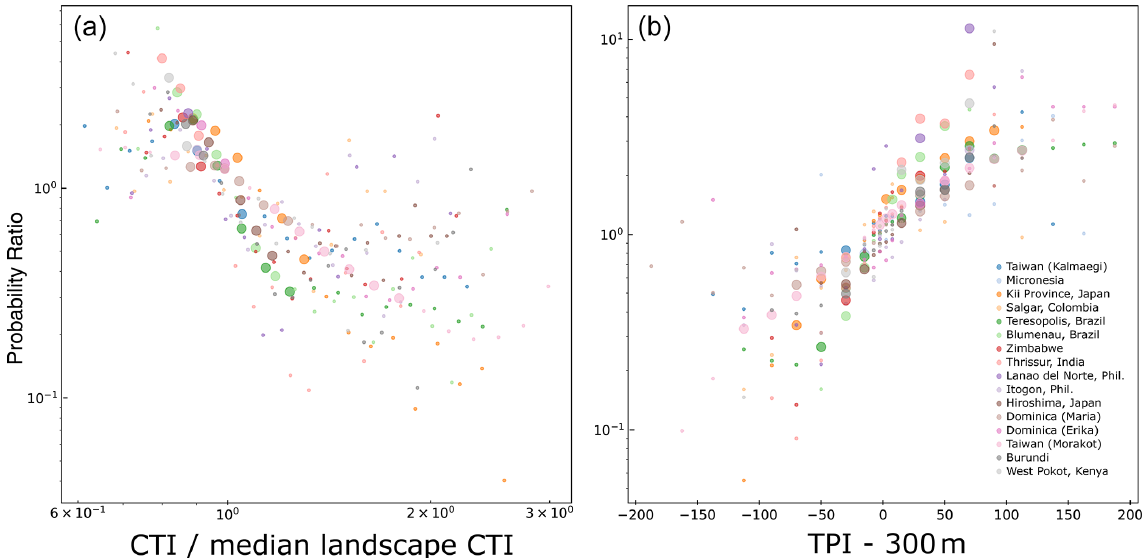
Figure 11. Probability ratio of landslide scar areas compared with the entire landslide area. It is important to note that while Figs. 3–9 contrast the landslide areas (scar or entire mapped area) with the topography, this figure shows the ratio of probabilities for the scar and whole landslide area. Specifically, this shows the probability of a scar at a given CTI value, normalized by the probability of that CTI value, divided by the probability of the entire landslide at a given CTI value, normalized by the probability of that CTI value. Higher values indicate that scars are more likely than whole landslide areas at that parameter value. Panel (a) shows the result for the CTI and panel (b) for the short-wavelength